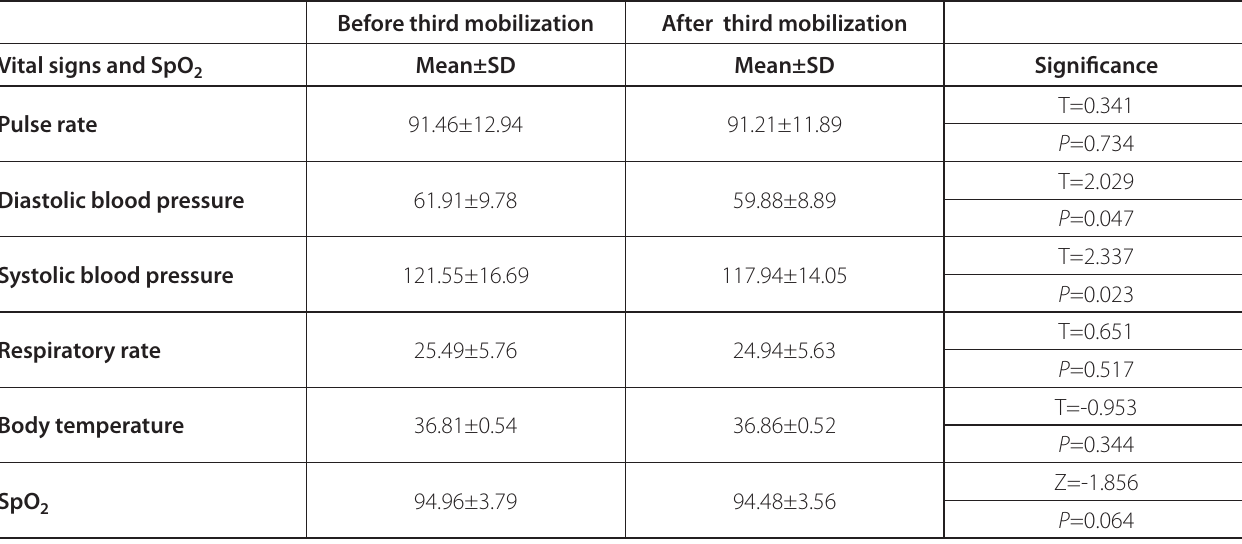
Table 4 . Comparison of vital signs and oxygen saturation levels obtained before and after the third mobilization session (n=67).